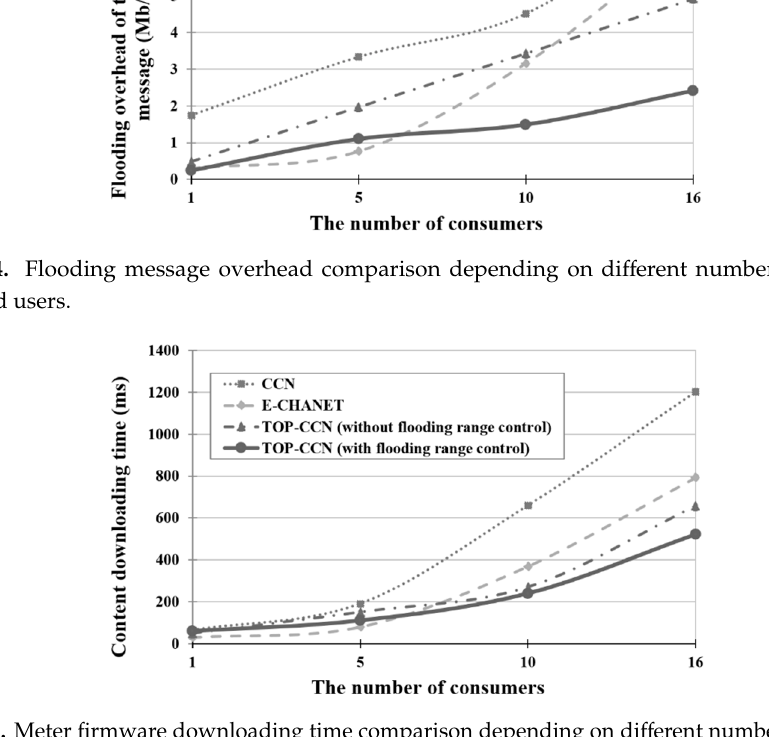
Figure 15. Meter firmware downloading time comparison depending on different number of firmware download users.